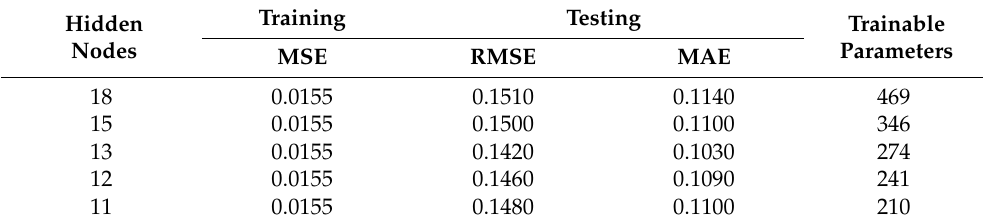
Table 12. Impact of hidden neurons on the performance of the model “RDM-1”. Hidden